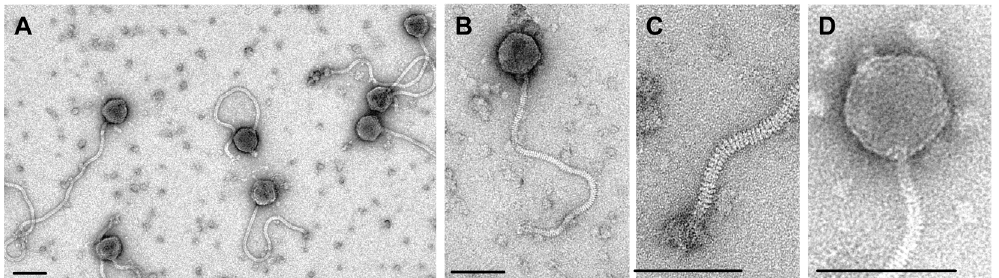
Figure 1. Electron microscopy of Tsamsa phage. TEM images were acquired from a preparation of pure phage particles negatively stained with 2% uranyl acetate on carbon-coated copper grids (Quantifoil, Jena, Germany) and observed using a Philips CM12 microscope at 120 kV acceleration voltage with a Gatan Orius digital camera. A. Preparation overview. B. Close-up of single phage particle. C. Details of the phage tail distal end. D. Details of the phage head structure. Individual capsomers are visible, an observation previously made for SPO1-related phages ([27]). Scale bars represent 100 nm.